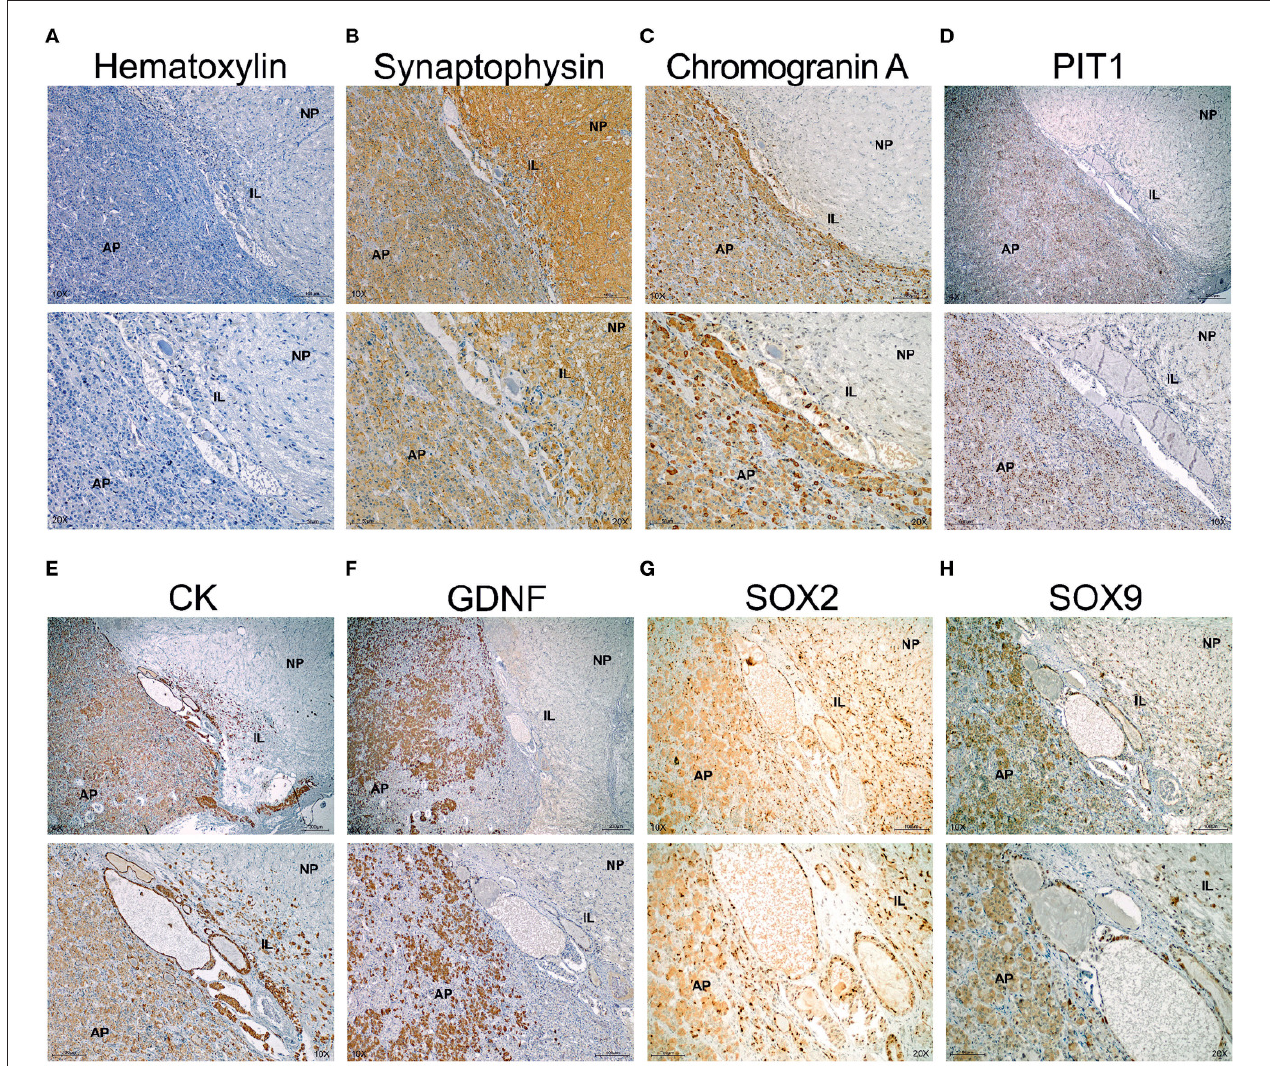
FIGURE 5 | The normal human pituitary co-express GPS stem cell markers at the epithelium of the RC. Immunohistochemistry in sagittal sections of human pituitary counterstained with Haematoxylin to reveal nuclei. Two magnifications are shown per field. (A) Negative control omitting primary antibody. No signal is seen and only remains the haematoxylin counterstain revealing the three portions of the pituitary. At the border between the IL and AP appears cysts (Rathke’s Cysts, RC), surrounded by a single layer of cells considered the GPS in humans. (B) Synaptophysin stains the NP, IL and less the AP. (C) Chromogranin A stains the AP. (D) PIT1 is a transcription factor express by differentiated somatotrophs, lactotrophs and thyrotrophs at the AP. (E) Cytokeratins (CK) are expressed by the epitheial endocrine cells. However, at the niche, the pituitary stem cells overexpress cytokeratins. (F) GDNF is the most abundant ligand of RET expressed at the adenopituitary. (G) SOX2 is a transcription factor expressed in many cells throughout the NP, IL, and AP. However, intensity is high at the stem cell niche formed by RC. (H) SOX9 is a transcription factor expressed by some cells at the NP and AP. Intensity is higher at the RC epithelium. AP, Adenopituitary; IL, Intermediate Lobe; NP,